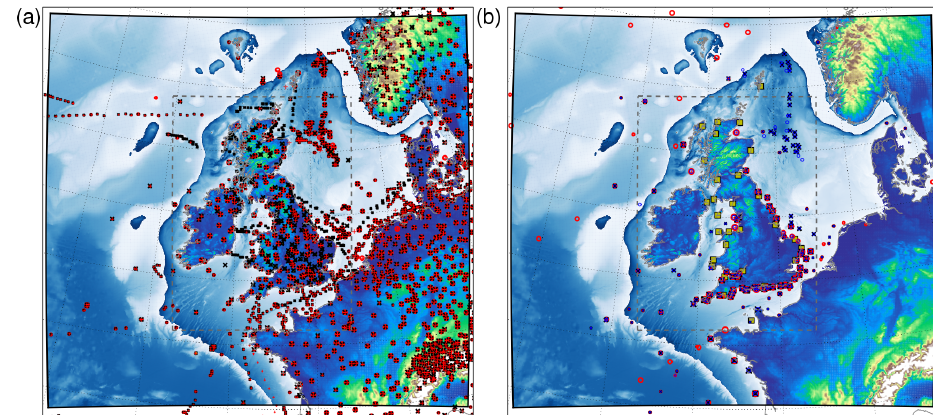
Figure 1. Illustration of the UKC3 domain showing the extent of atmosphere/land model domain orography and ocean/wave model domain bathymetry. The regular 1.5km resolution inner region of the atmosphere model grid is indicated by the dashed grey line. (a) Location of sample of in situ observations on 15 July 2014, relevant for evaluating atmosphere model results. Key to symbols: red circle – visibility, black cross – air temperature and red cross – wind speed and direction. (b) Location of in situ observations on 15 July 2014 relevant for evaluating ocean and wave components. Key: yellow squares – tide gauge sea surface height, red circle – sea surface temperature, black cross – peak wave period and blue circle – significant wave